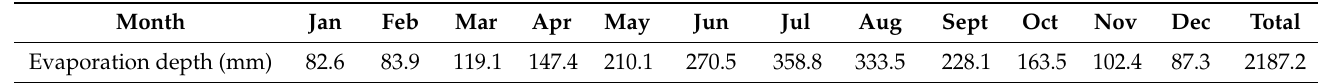
Table 1. Mean monthly evaporation data